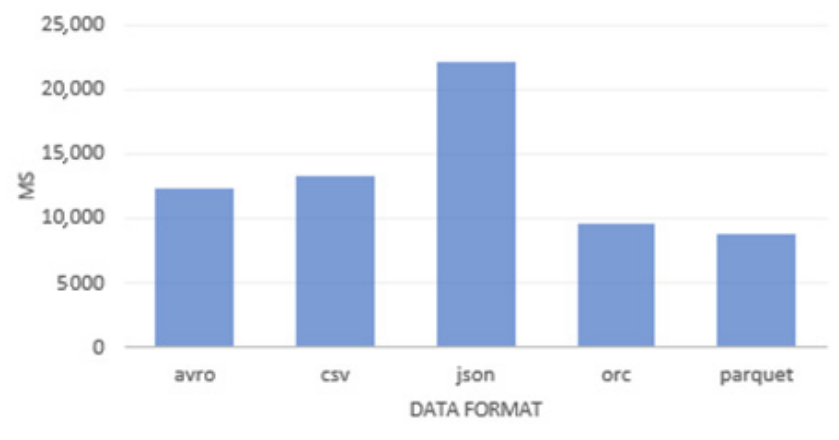
Figure 6. Time assessment of storage formats. The result of estimating the data volume is shown in Figure 7.